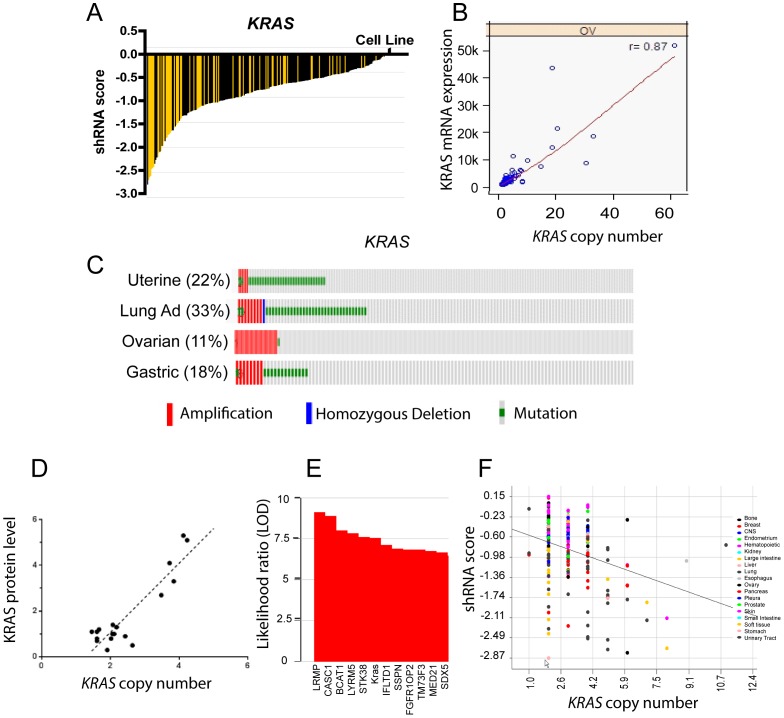
Cancer amplified genes in the MAP kinase pathway.(A) KRAS shRNA activity in a panel of cancer cell lines (Project Achilles). shRNA score denotes the log2 based decrease in KRAS shRNA compared to pooled shRNA in cancer cell lines after several rounds of proliferation post-shRNA infection [11]. A negative shRNA score suggests decreased cancer cell proliferation/survival after shRNA transfection. Yellow bars indicate cell lines with KRAS copy number >4 and black bars indicate cell lines with KRAS copy number <4. (B) Copy number (x-axis) and mRNA expression (y-axis) for KRAS in a panel of ovarian cancers. Correlation coefficient for copy number and mRNA expression are listed in the top right (r value). (C) Frequency of amplification (red bar), mutation (green bar), and deletion (blue bar) for KRAS in various cancers. The percentages shown reflect the overall rate of gene amplification, mutation and/or deletion in each cancer type. Vertical aligned bars reflect samples from the same patient. (D) KRAS copy number (x-axis) and KRAS relative protein level (y-axis) as measured by western blot in a panel of lung cancer cell lines grown in vitro. (E) Gene amplifications associated with sensitivity to KRAS shRNA in cancer cell lines (Project Achilles). Y-axis = Log10 Likelihood Ratio (LOD) of gene amplification being associated with shRNA score by comparing each gene amplification model to the “null model” without any gene amplification. (F) KRAS copy number (x-axis) and KRAS shRNA score (y-axis) for individual cancer cell lines color-coded by tumor type (data obtained from Project Achilles). Trendline shown for mean values in each copy number bin.